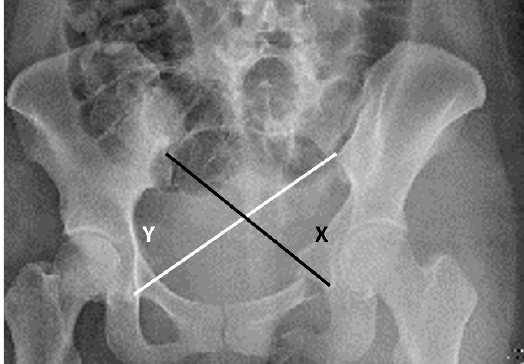
Figure 4. The cross − measurement method is illustrated with an example image.